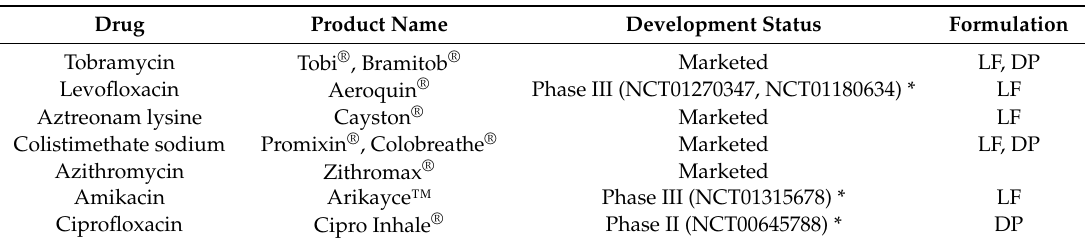
Table 1. Inhaled antimicrobials marketed or undergoing clinical trials for treatment of P. aeruginosa infections in CF patients. Adapted from